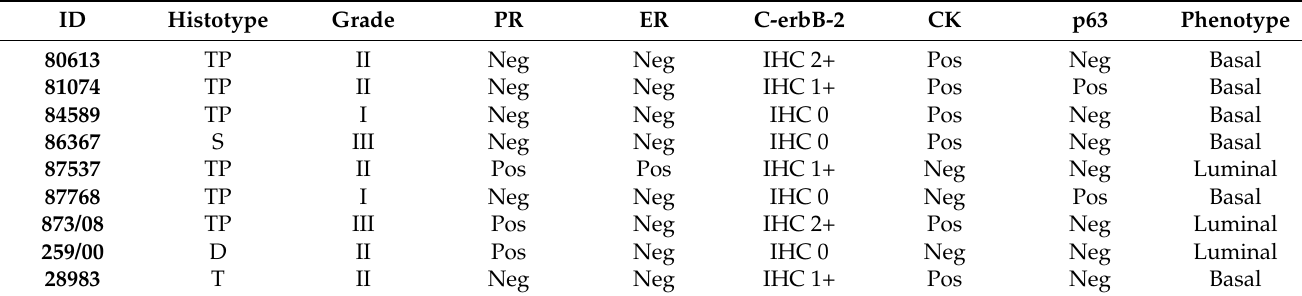
Table 3. Main histopathological features of the MMTV-like positive feline mammary